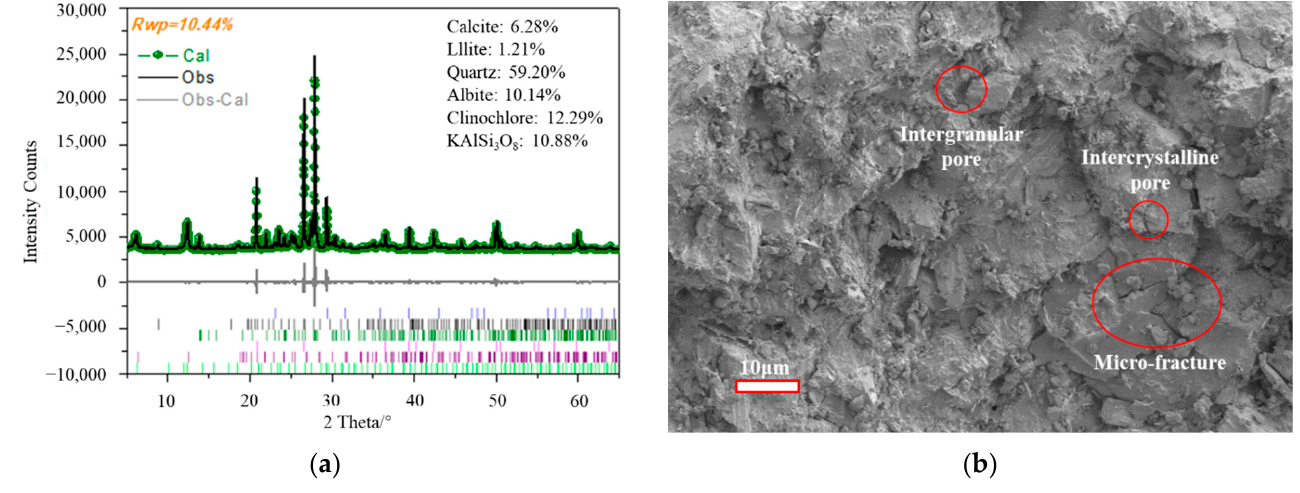
Figure 1. The ( a ) XRD and ( b ) SEM test results.